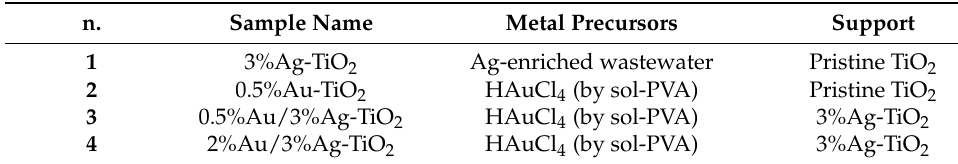
Table 6. List of the synthesized photocatalysts with main